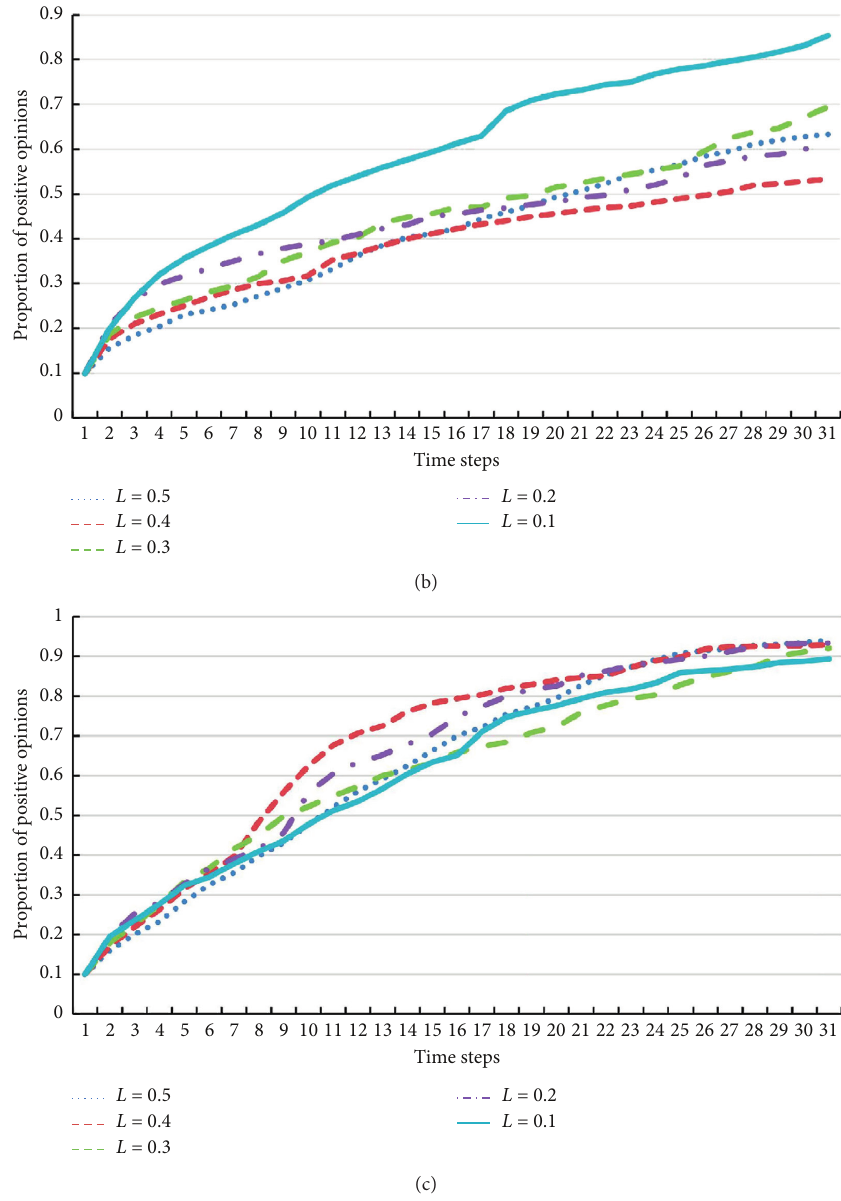
Figure 3: The evolution trends for the initial proportion pp � 0 . 1, opinion control levels k � 1 , 3 , and 5, and L � 0 . 5 , 0 . 4 , 0 . 3 , 0 . 2 , and 0 . 1 in � 20 and m � 5. (a) The initial proportion pp � 0.1, C � 2, and L � 0.5, 0.4, 0.3, 0.2, and 0.1. (b) The initial scale-free networks with m 0 proportion pp � 0.1, C � 6, and L � 0.5, 0.4, 0.3, 0.2, and 0.1. (c) The initial proportion pp � 0.1, C � 10, and L � 0.5, 0.4, 0.3, 0.2, and